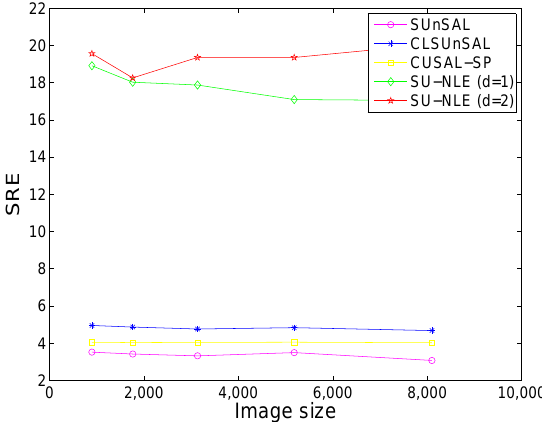
Figure 19. SREs of different methods as a function of varying image size under correlated noise with only mixed regions having 64 × 64 pixels, 4 endmembers and 224